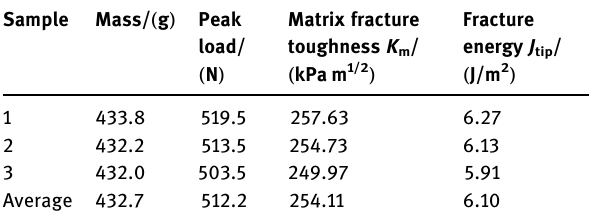
Table 3: Fracture toughness of the matrix Sample